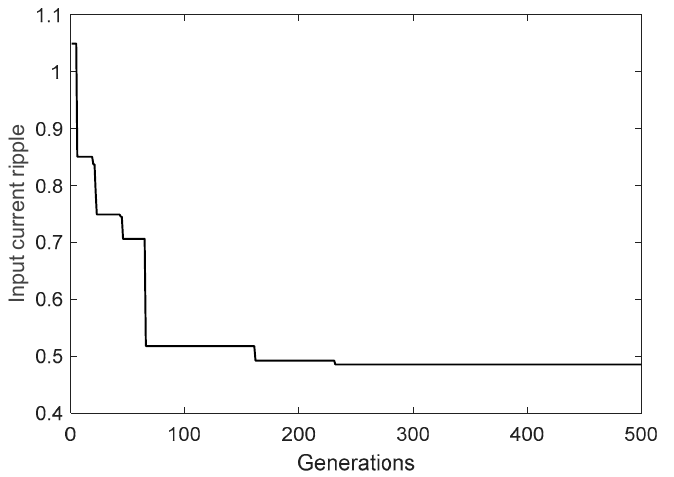
Figure 11. Convergence graph of the Differential Evolution (DE) algorithm considering G = 5 on a single execution.